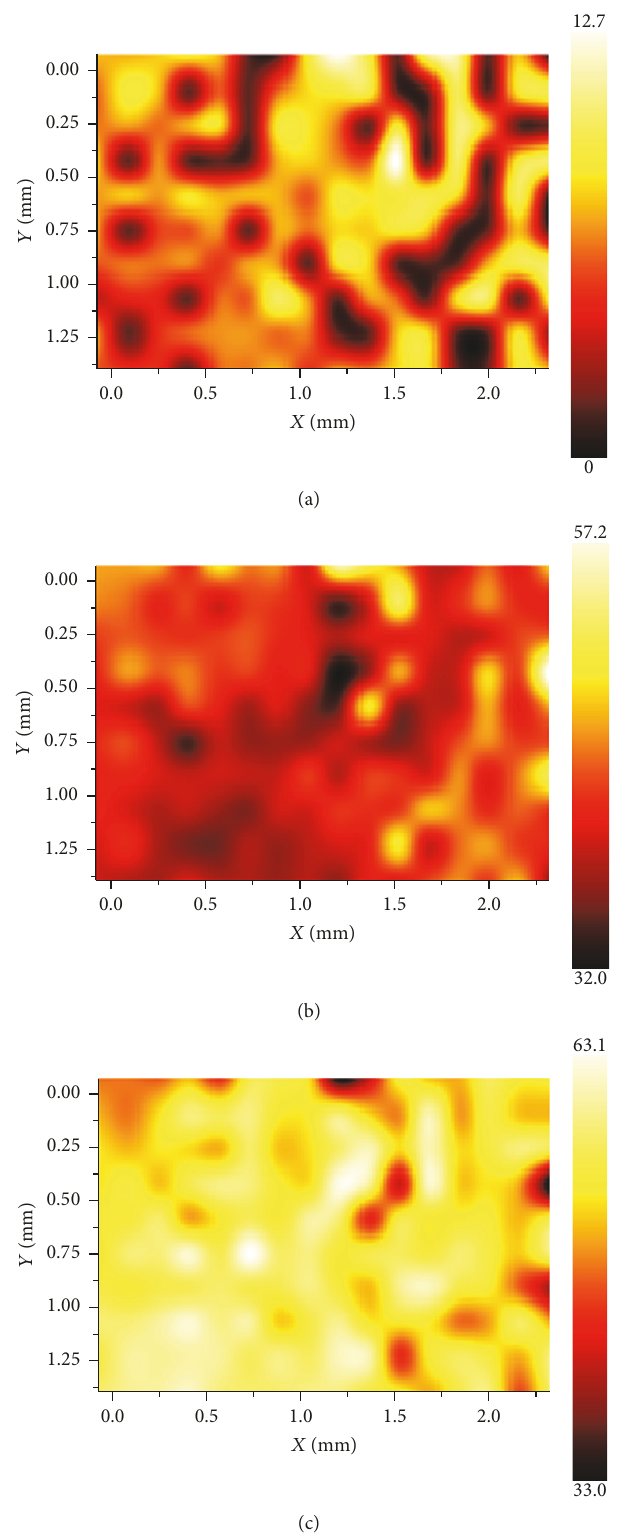
Figure 15: XPS maps for the atomic percentages of (a) Al2p; (b) O1s; and (c) Mg1s for the AZ91D alloy immersed for 3 h in 3.5 wt.% NaCl solution at room